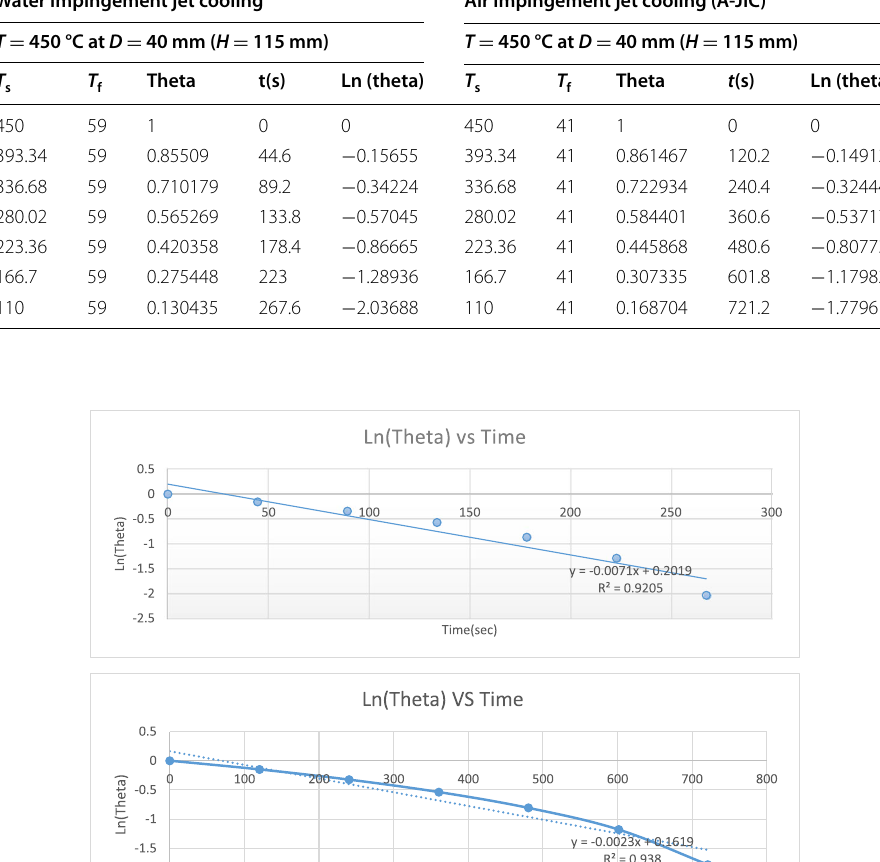
Fig. 9 Ln(theta) temperature time at 110 °C for D